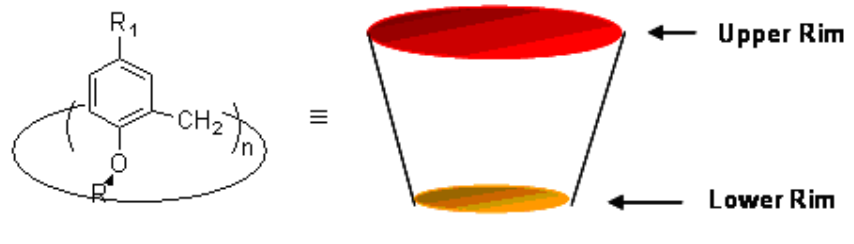
Figure 1. Molecular structure of